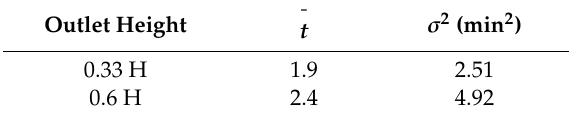
Table 4. Mean residence time and variance of RTD for di ff erent outlet heights (J type inlet).